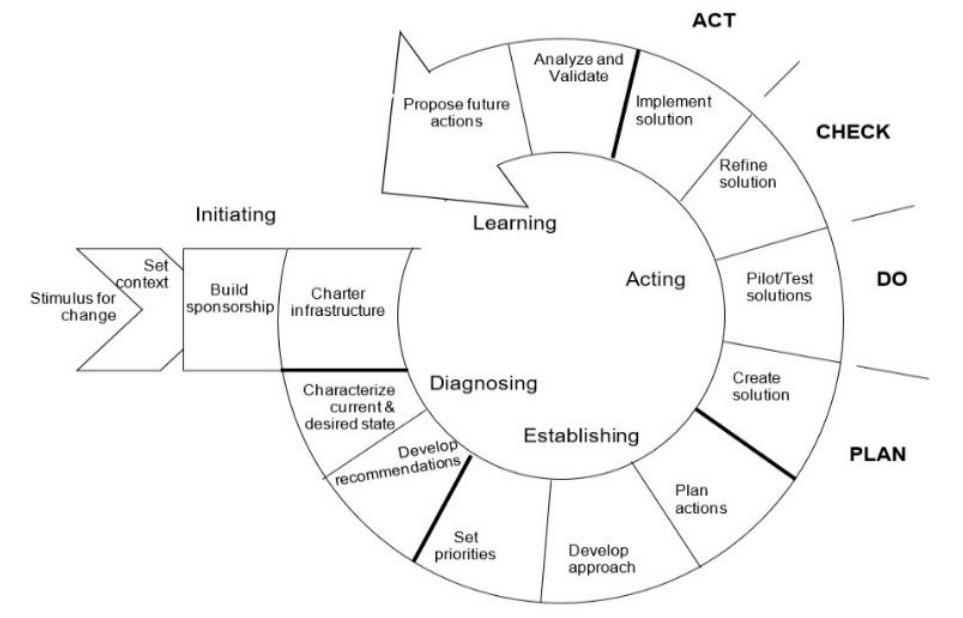
Figure 3. IDEAL process improvement life